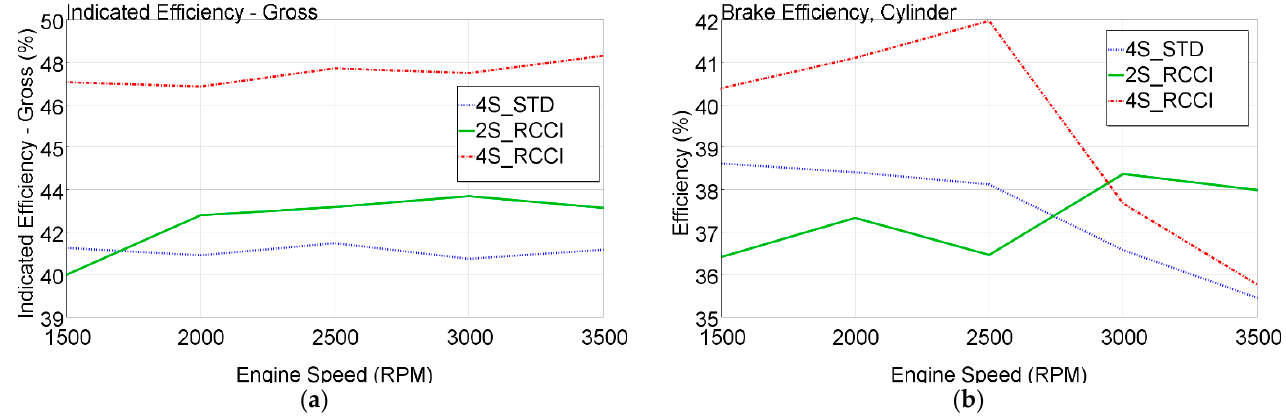
Figure 11. Indicated efficiency ( a ) and brake efficiency ( b ) comparison between base diesel engine, 4-stroke RCCI engine and 2-stroke RCCI engine. Operating point 1500–3500 rpm at full